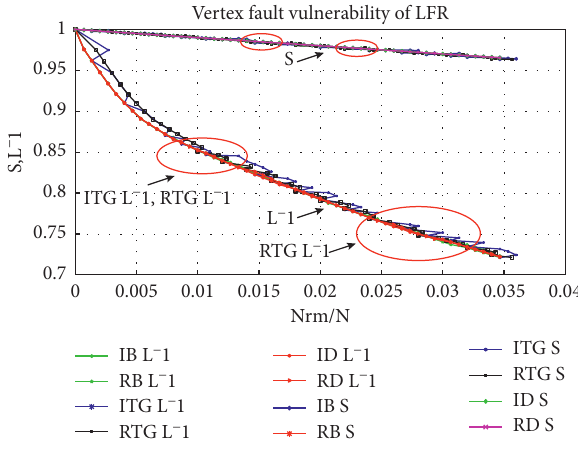
Figure 7: l − 1 & S result of